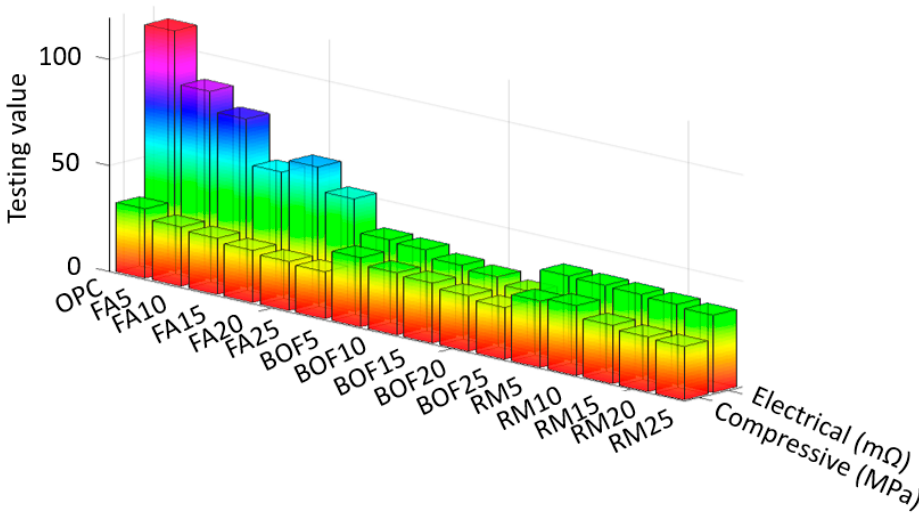
Figure 8. Compressive strength and electrical resistance results for the environment-friendly, self-sensing concrete cured at the age of 28 days.